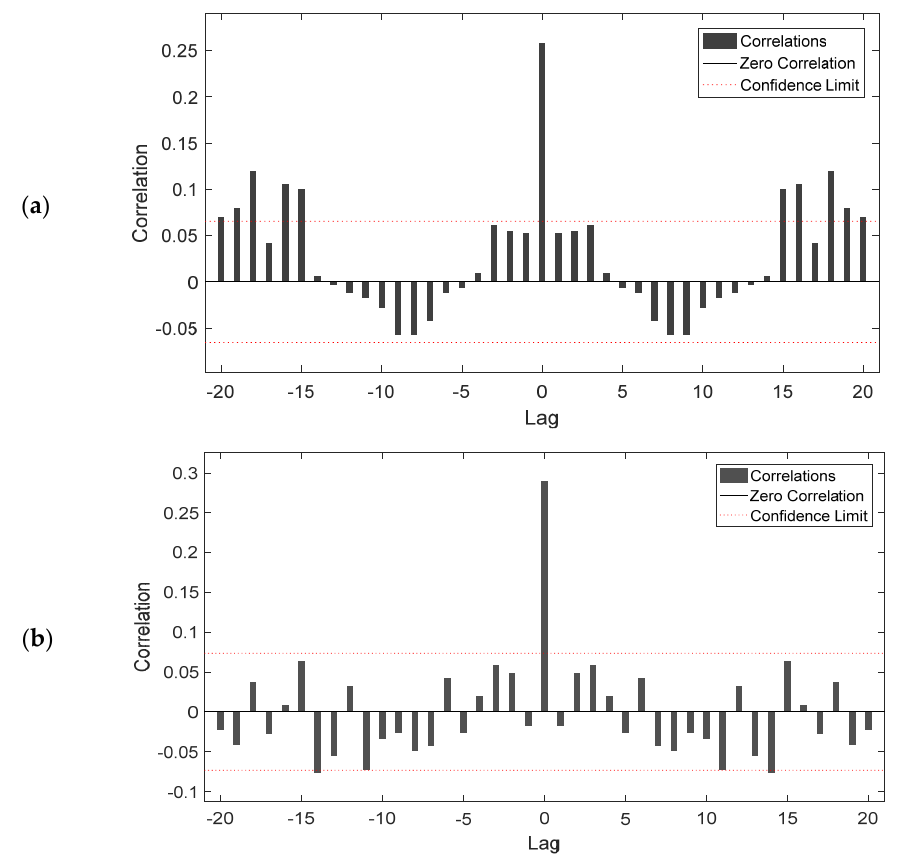
Figure 7. Autocorrelation values of the NARX ( a ) and the FTD ( b ) model in respect to different time lags and related confidence limits.